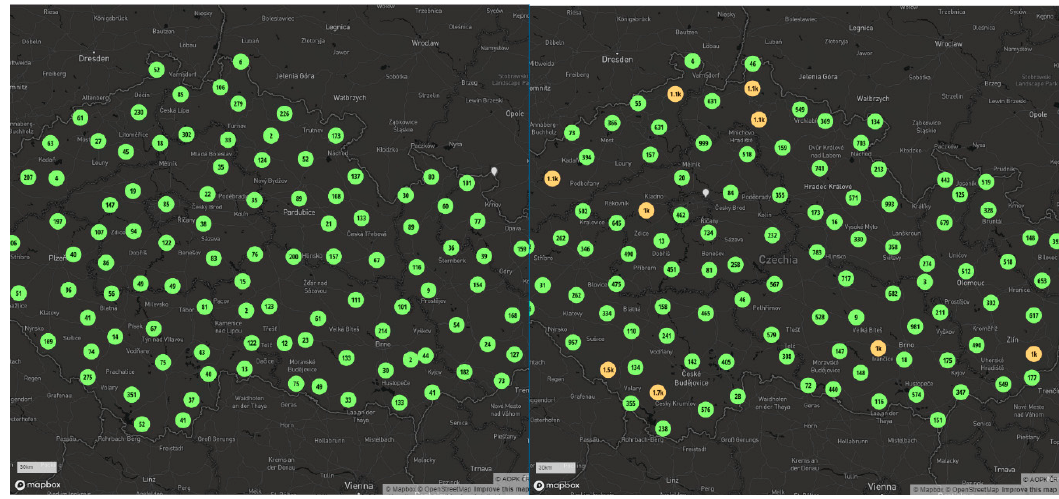
Figure 6. Map output of Mapbox GL JS (Graphics Library JavaScript)—testing on 10,000 and 50,000 of points.